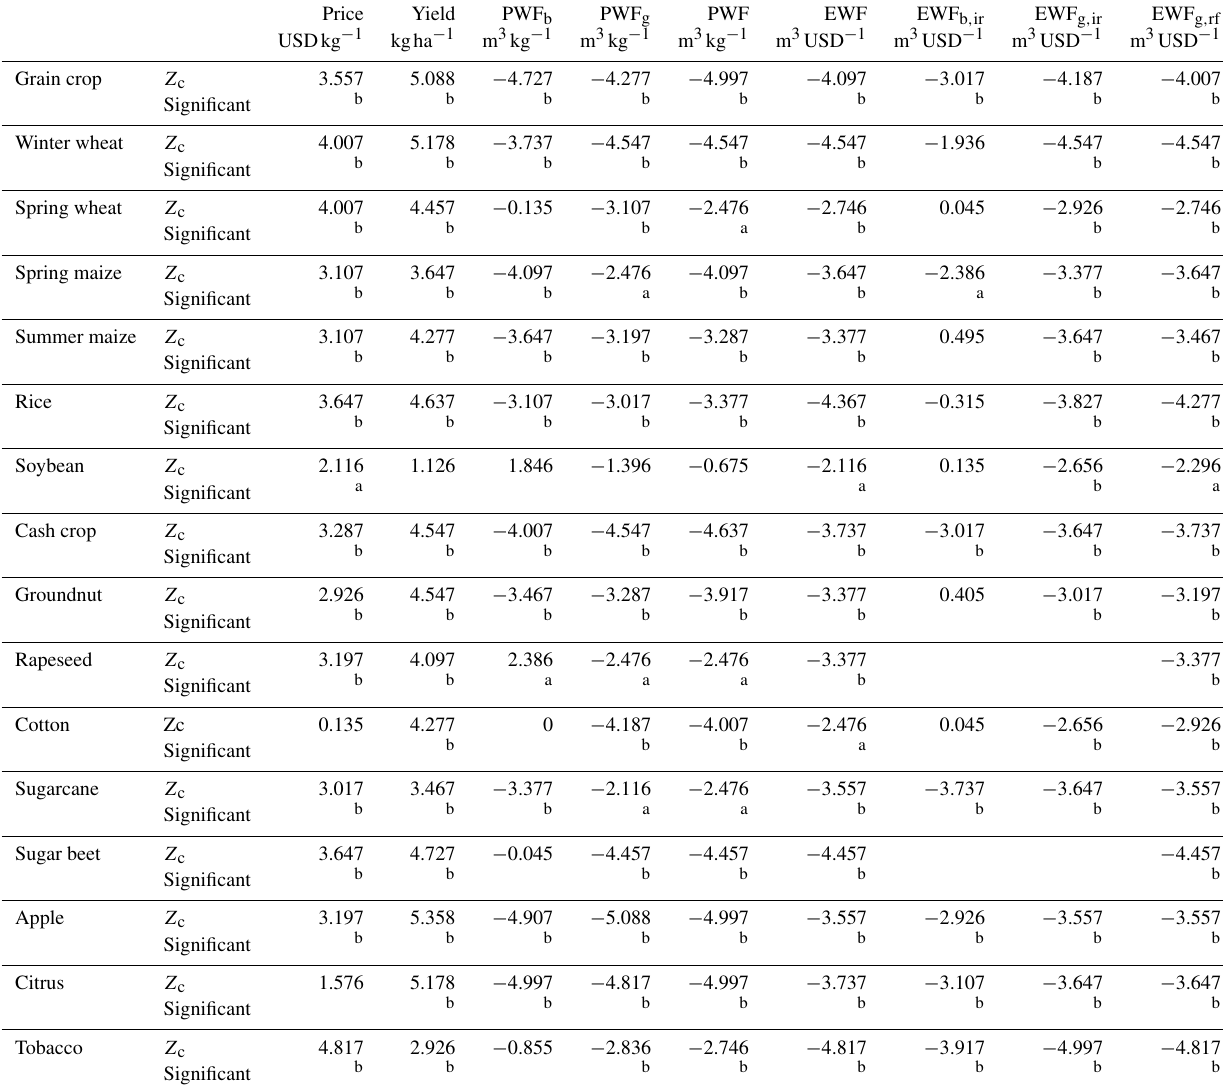
Table 3. M–K analysis of production-based water footprint (PWF) and economic value-based water footprint (EWF) of crops in China. Price Yield PWF b PWF g PWF EWF EWF b , ir Grain crop Z c